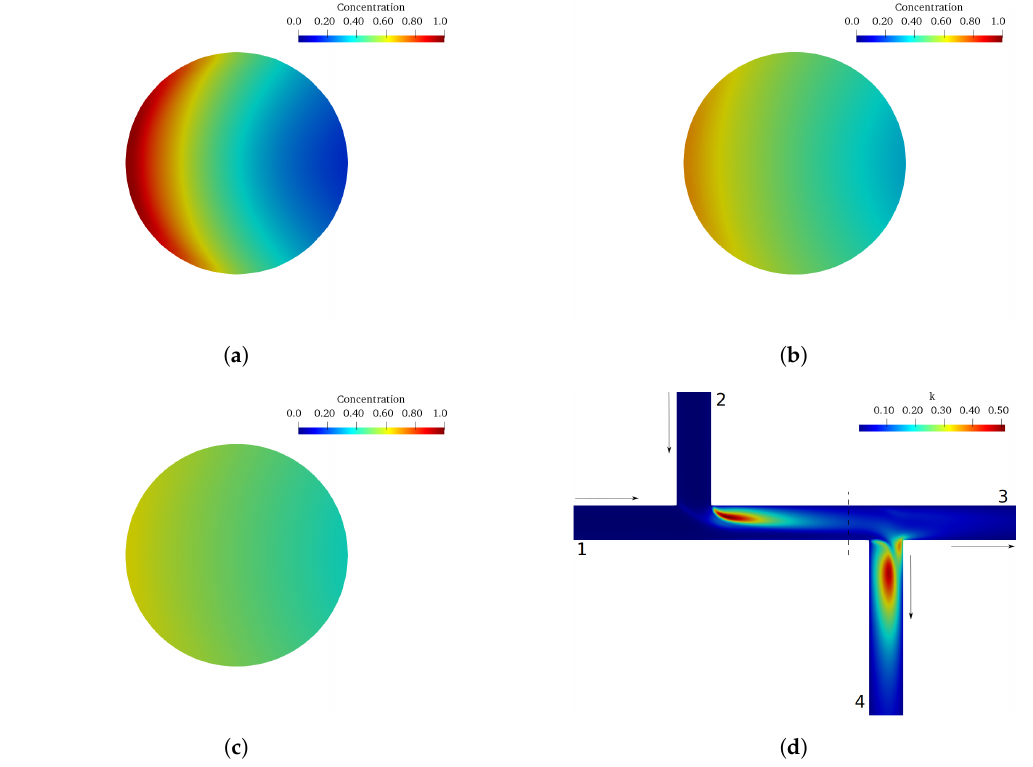
Figure 2. Concentration at pipe cross sections (1.67 D before the center-line of branch outlet pipe 4 and all cross sections are perpendicular to fluid flow) and turbulence kinetic energy with R q R q equal to 1 for all cases: ( a ) cross section concentration for 5.6 D ; ( b ) cross section concentration for out 10 D ; ( c ) cross section concentration for 15 D ; and ( d ) turbulence kinetic energy k (m 2 /s 2 ) for 5.6 D (plan view), where arrows represent the flow direction and a dashed line the position of the cross section of the 5.6 D